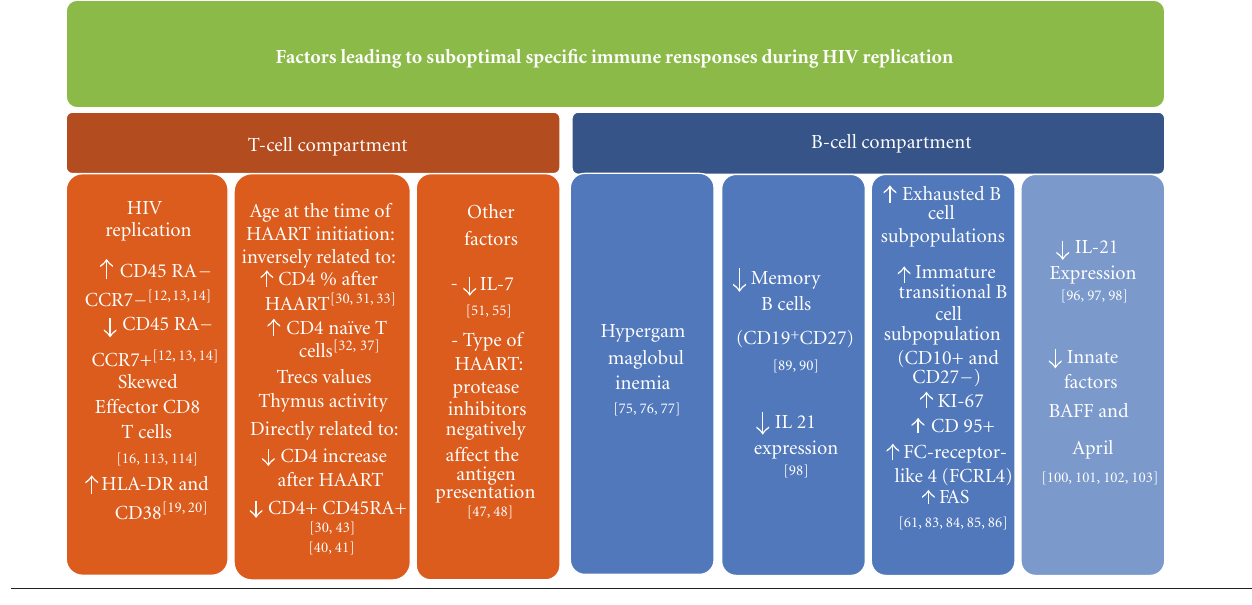
Table 1: Factors leading to suboptimal immune reconstitution in vertically HIV infected